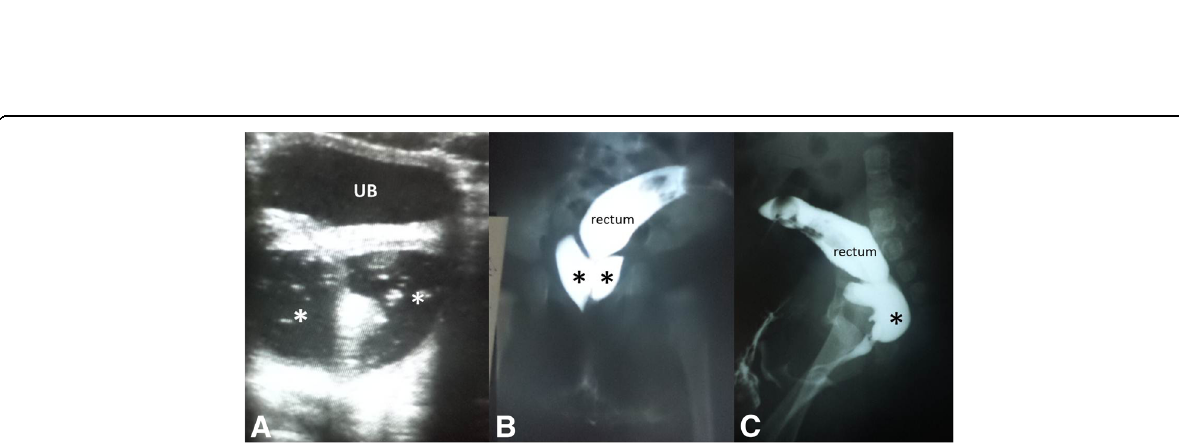
Fig. 16 Cloacal anomalies in a neonate. a US image illustrating two cystic lesions (*) behind the urinary bladder (UB). b , c AP and lateral colostogram images showing the rectum and cloacal cystic lesions